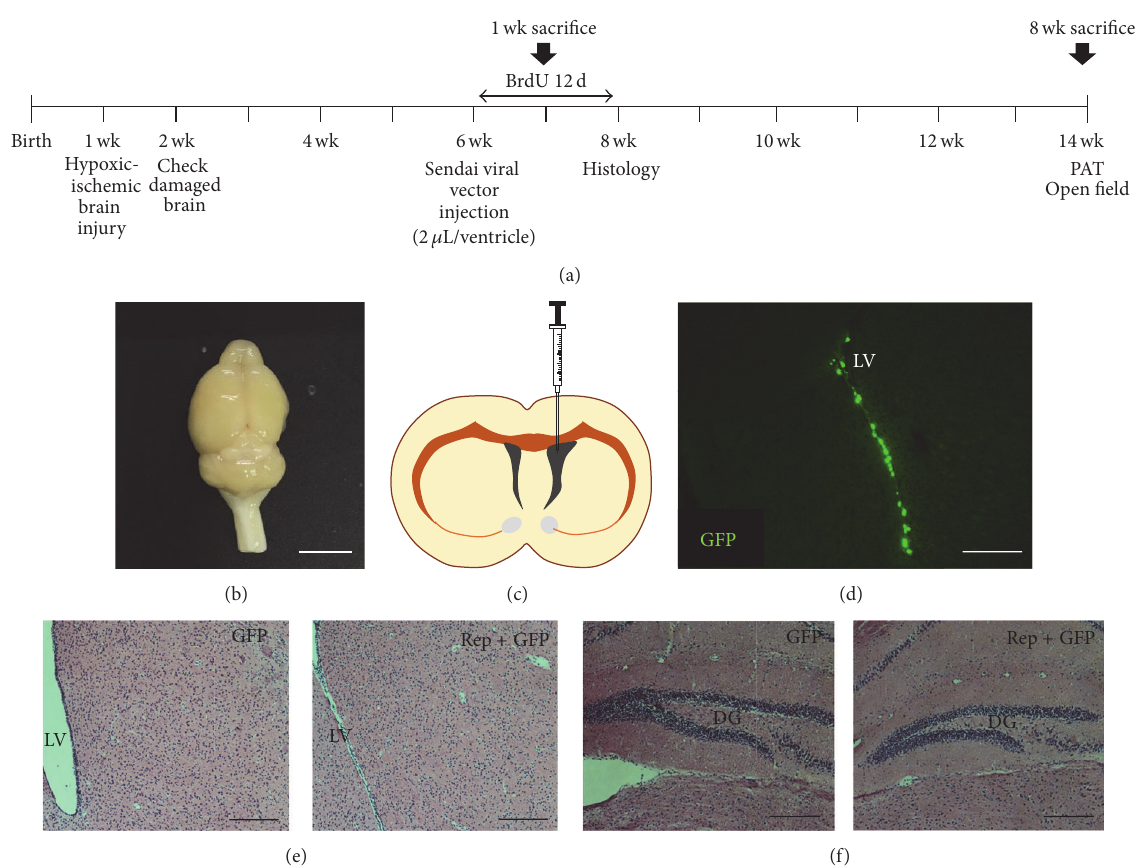
Figure 1: Experimental design and intraventricular injection of reprogramming factors. (a) Schematic timeline of the experiment. (b) A brain picture of chronic hypoxic-ischemic brain injury model. Scale bar = 0.5 cm. (c) At postnatal 6 weeks, mice were injected in the right side of lateral ventricle with GFP and the four reprogramming factors, that is, Oct4 , Sox2 , c- Myc , and Klf4 (treatment group), or GFP only (control group). (d) An image of GFP expression in the lateral ventricle. Scale bar = 200 𝜇 m. (e) Absence of dysplasia or tumor development in the lateral ventricle. (f) Absence of dysplasia or tumor development in the hippocampus. Both samples of (e) and (f) were evaluated 8 weeks after the treatment, and brain sections were stained with hematoxylin and eosin and observed using a microscope. Neither dysplasia nor tumors were observed in any group. Scale bars = 200 𝜇 m. PAT, passive avoidance task; LV, lateral ventricle; DG, dentate